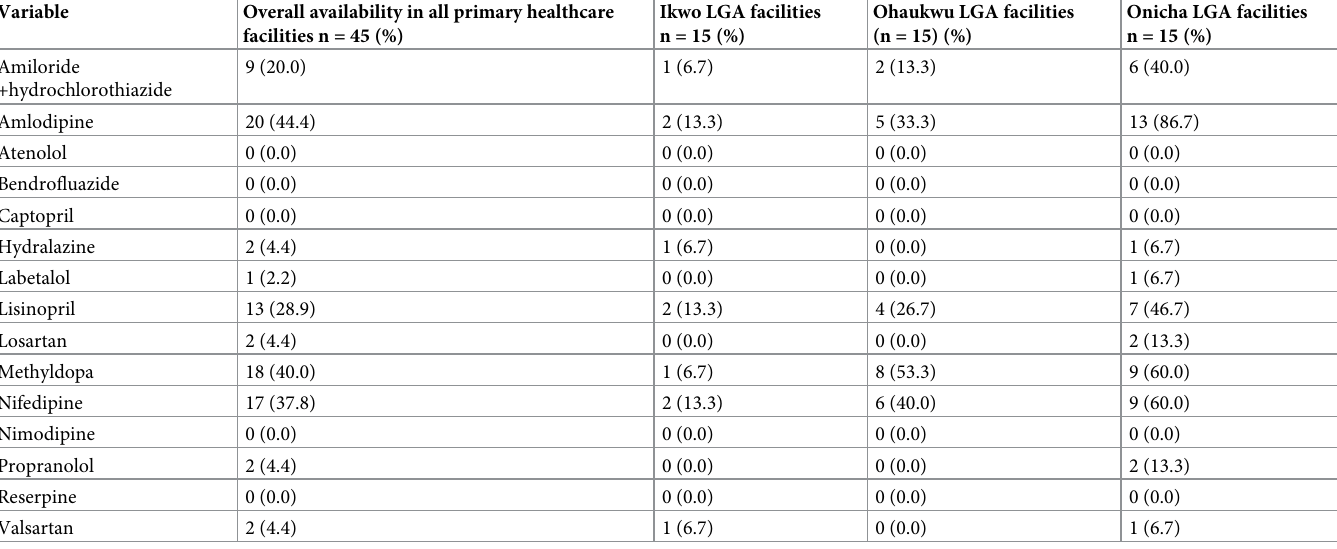
Table 1. Availability of essential medicines for control of hypertension in primary healthcare facilities in Ebonyi State, Nigeria.